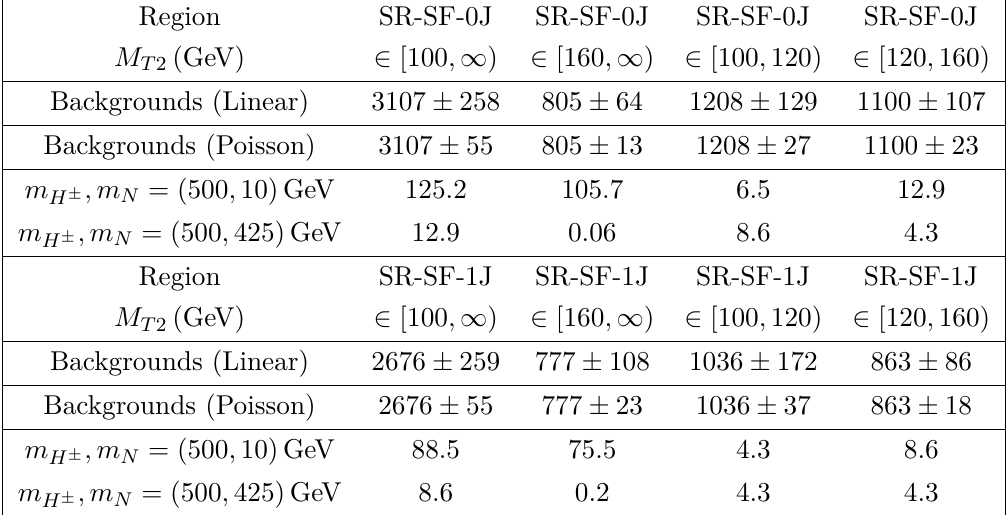
linearly (assuming 139fb − 1